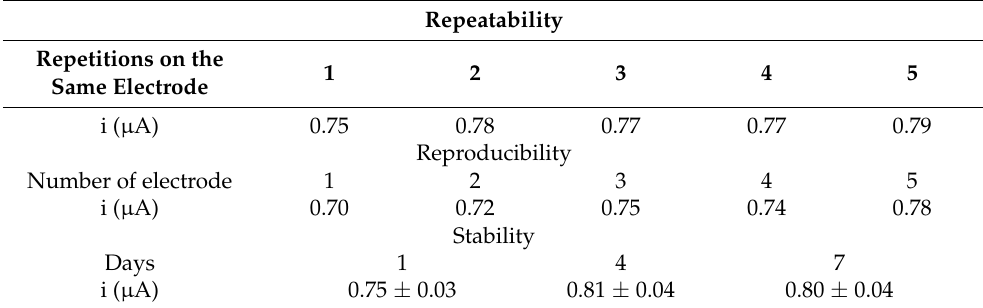
Table 1. Precision parameters characterizing the developed aptasensor based on Apt-Fc.